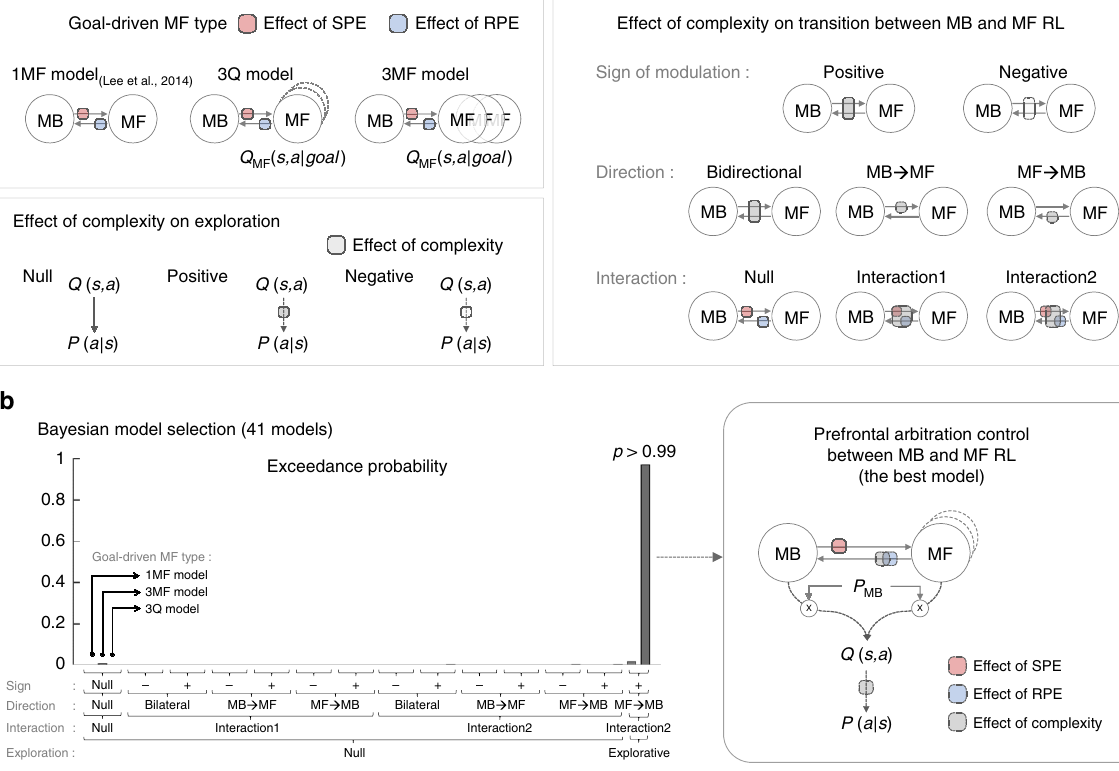
Fig. 5 Model comparison analysis on behavioral data. a We ran a large-scale Bayesian model selection analysis to compare different versions of arbitration control. These model variants were broadly classi fi ed as re fl ecting the effect of complexity on the transition between MB and MF RL (13 = 1 + 2 × 2 × 3 types), the effect of complexity on exploration (3 variants), and the form of the MF controller (3 variants) each of which is classi fi ed by a type of goal- driven MF (3 types), an effect of complexity on transition between MB and MF RL, and an effect of complexity on exploration (3 types). Lee2014 refers to the original arbitration model 30 . b Results of the Bayesian model selection analysis. Among a total of 117 versions, we show only 41 major cases for simplicity, including the original arbitration model and 40 other different versions that show non-trivial performance (but the same result holds if running the full model comparison across the 117 versions). The model that best accounts for behavior is the version {3Q model, interaction type2, excitatory modulation on MF → MB, explorative} (exceedance probability >0.99; model parameter values and distributions are shown in Supplementary Table 1 and Supplementary Fig. 3,